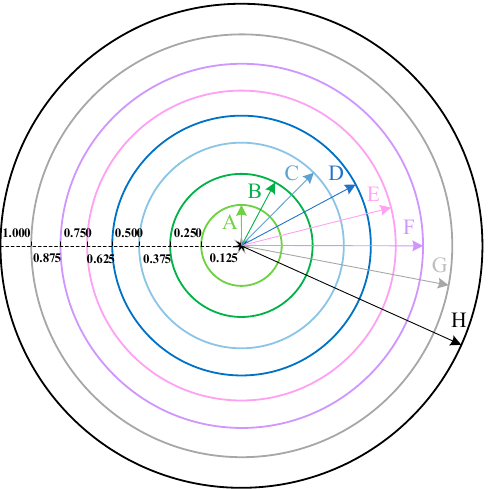
Figure 7. Schematic diagram of the communication range when the splitting factor a=8.